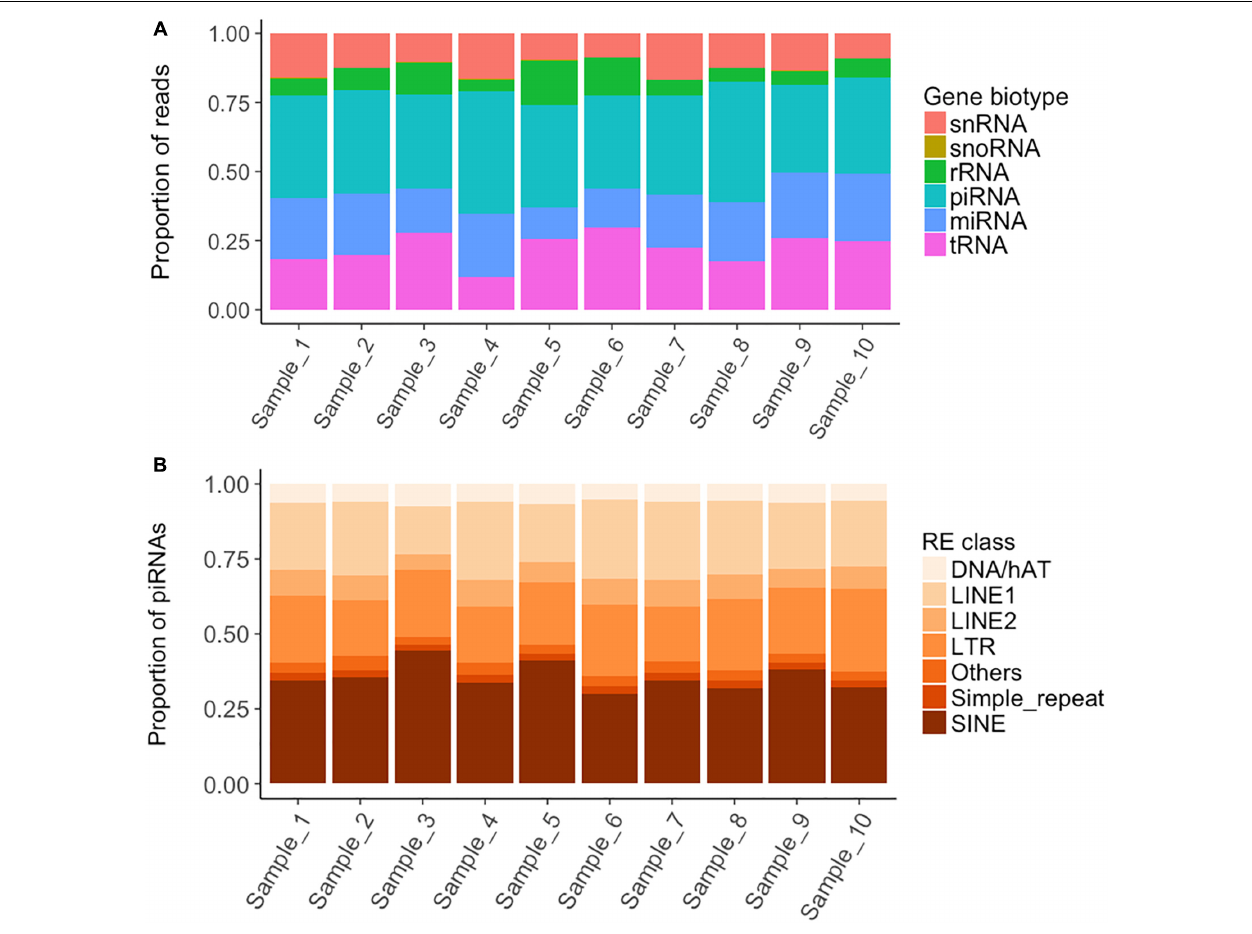
FIGURE 2 | Read mapping distribution of the short non-coding RNA types and piRNA distribution within the Repetitive Element classes. (A) Proportion of reads mapping to each short non-coding RNA type. (B) Distribution within each Repetitive Element class of the piRNA cluster reads overlapping with Repetitive Elements.